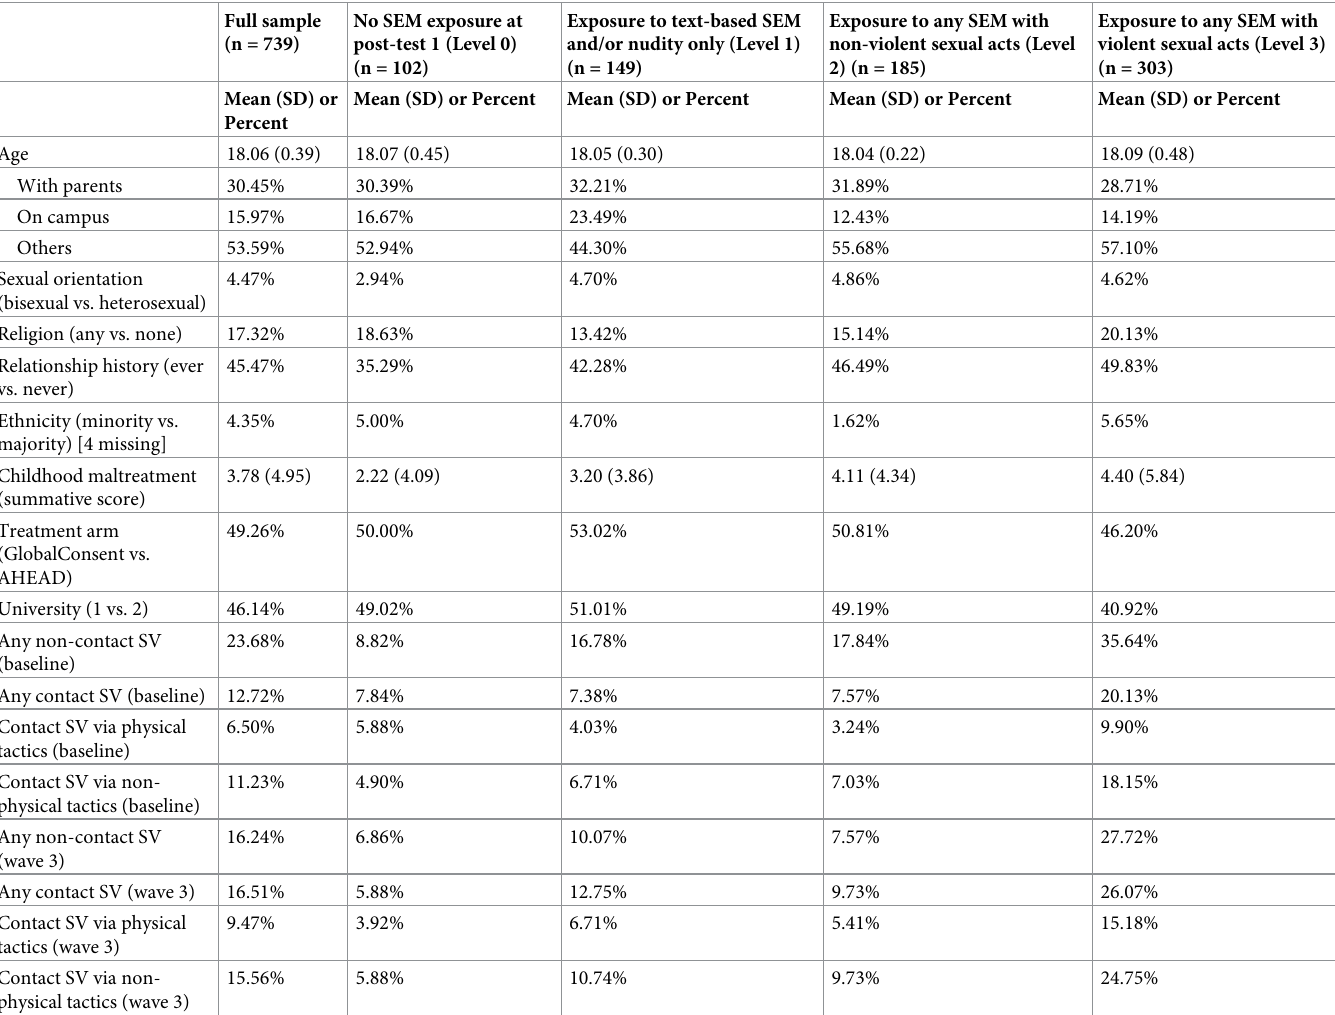
Table 1. Characteristics of first year university men in Hanoi, Vietnam by SEM exposure level (n =